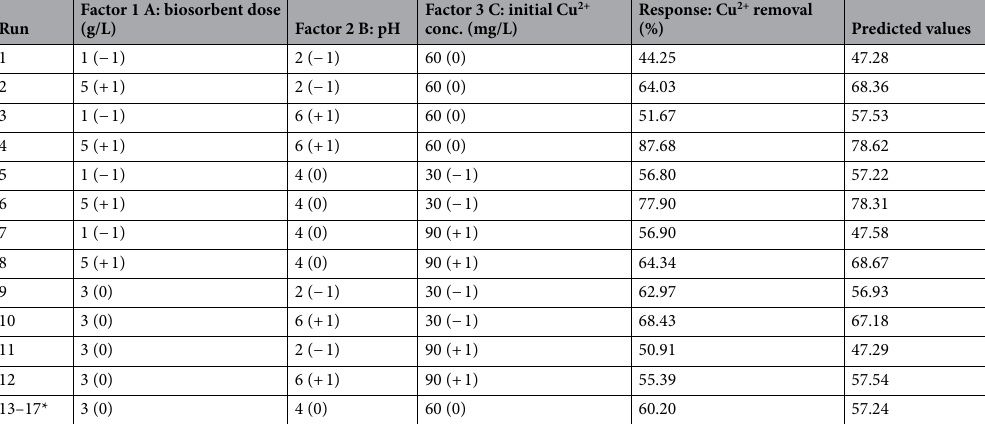
Table 1. Box–Behnken design factors with coded and un-coded factors and data of the experimental response. *Mean value of five center point assays.